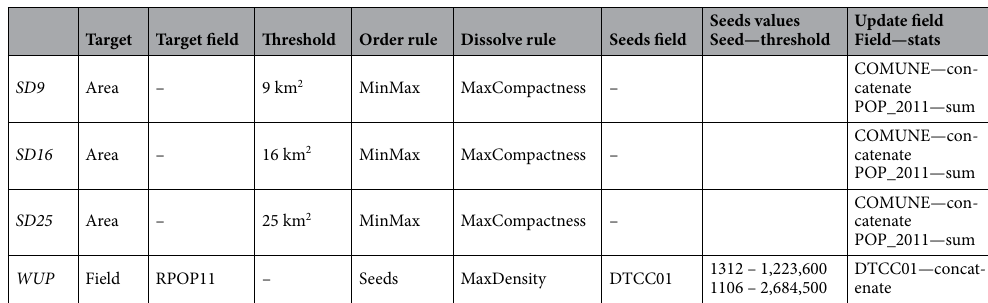
Table 2. Parameter settings used for the example applications considered in this analysis. The WUP application also uses the ‘ Bound Adjacency Field ’ parameter enabled and set to NUTS3 (i.e. the upper administrative level; Nomenclature of Territorial Units for Statistics, for explanation see https:// ec. europa. eu/ euros tat/ stati stics- expla ined/ index. php? title= Gloss ary: Nomen clatu re_ of_ terri torial_ units_ for_ stati stics_